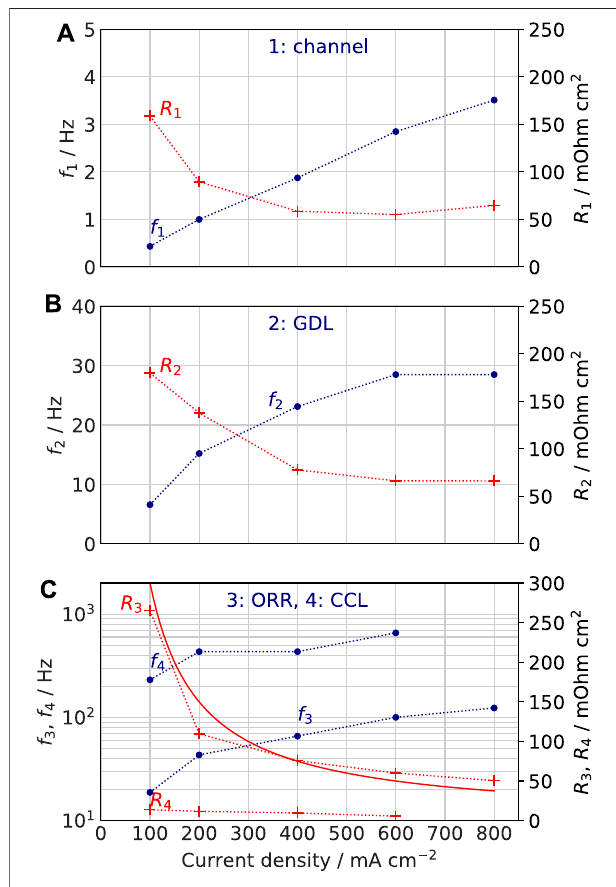
FIGURE 8 | Frequency and resistivity of the DRT peaks calculated using K 2 kernel ( Figure 7 ) versus mean cell current density J . Solid line in (C) is the TafelORRresistivity R ORR (cid:1) b / J plottedwiththeTafelslope b (cid:1) 0.03 V(69 mV/ decade). (A) fi rst peak, (B) second peak and (C) third and fourth